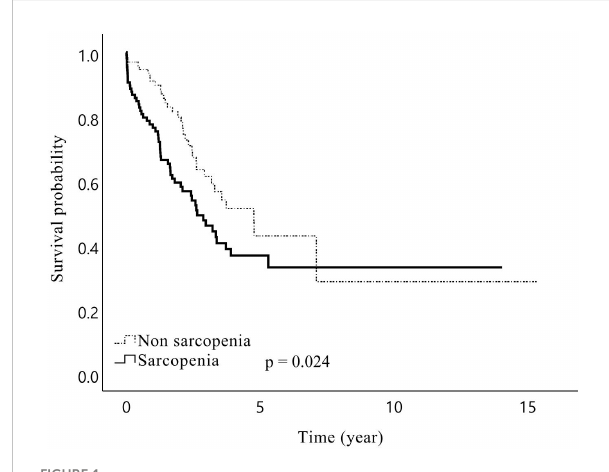
FIGURE 1 Kaplan – Meier curves for overall survival after hepatic resection of Klatskin tumors for male patients strati fi ed by presence of preoperative sarcopenia. Overall survival for male patients with sarcopenia following surgery of Klatskin tumors was shorter than for those without